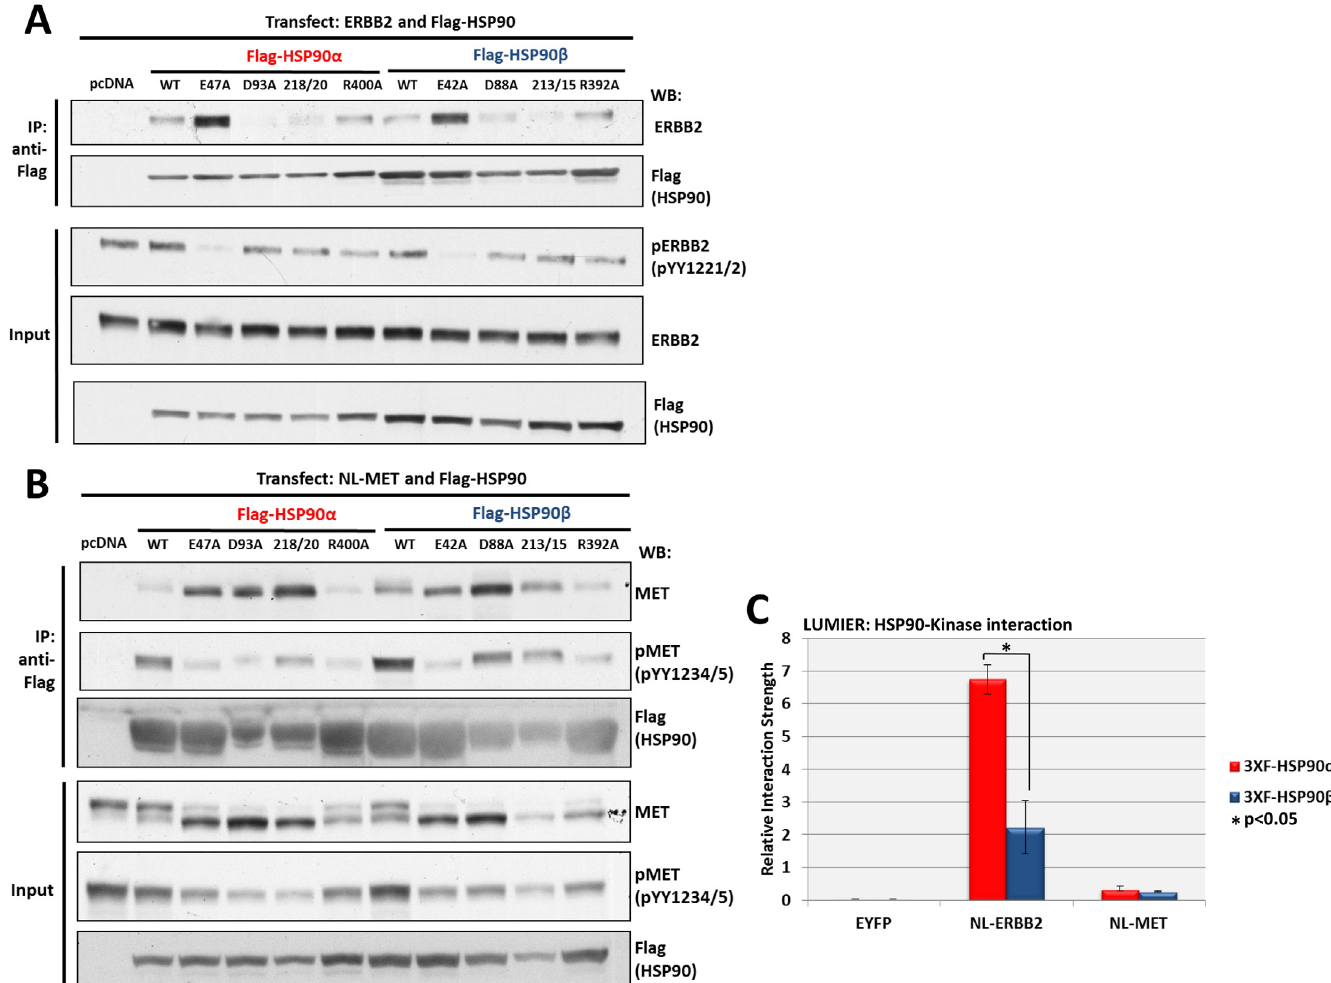
Fig 3. Interaction of ERBB2 and MET with HSP90 isoforms. (A) ERBB2 interaction with HSP90 WT and mutants: HEK293 cells transfected with ERBB2 and each FLAG-HSP90 construct were harvested, immunoprecipitated with anti-FLAG beads and western blotted for ERBB2 interaction and pY1221/ pY1222 intensity. Input lysates were normalized and run as controls. (B) MET interaction with HSP90 WT and mutants: HEK293 cells transfected with MET and each FLAG-HSP90 construct were harvested, immunoprecipitated with anti-FLAG beads and western blotted for MET interaction and pY1234/1235 intensity. Input lysates were normalized and run as controls. (C) Measurement of the relative interaction strength of ERBB2 and MET with each HSP90 isoform by LUMIER: HEK293 cells transfected with MET or ERBB2 and each HSP90 isoform were harvested, applied to a 96-well anti-FLAG plate and assayed for luciferase activity. The difference in relative interaction strength of HSP90 α and HSP90 β for ERBB2 ( > 3-fold) was statistically significant (p < 0.05) (see